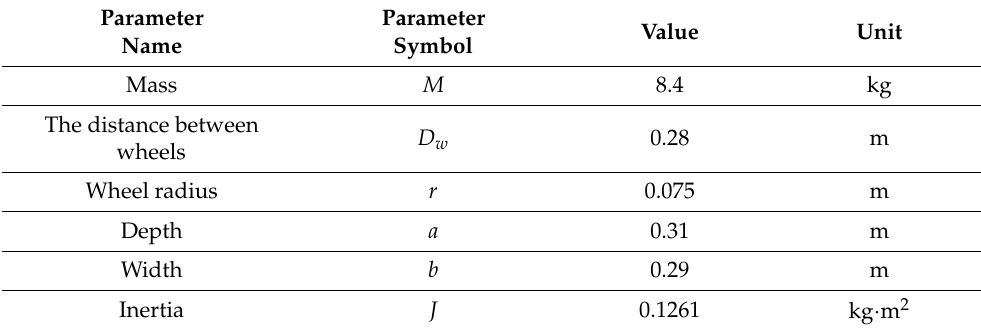
Table 4. The parameters of the robot